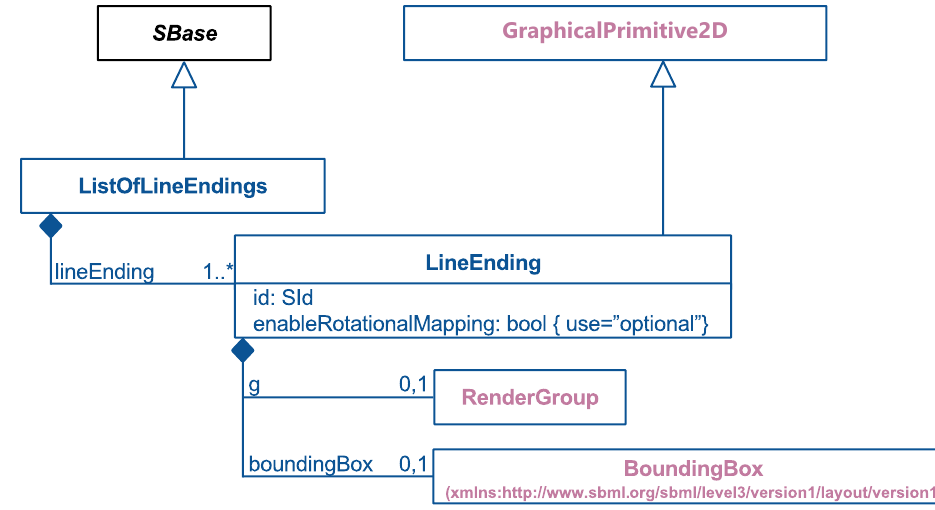
Figure 14: A UML representation of the LineEnding class for the Render package. See Section 1.4 for conventions related to this